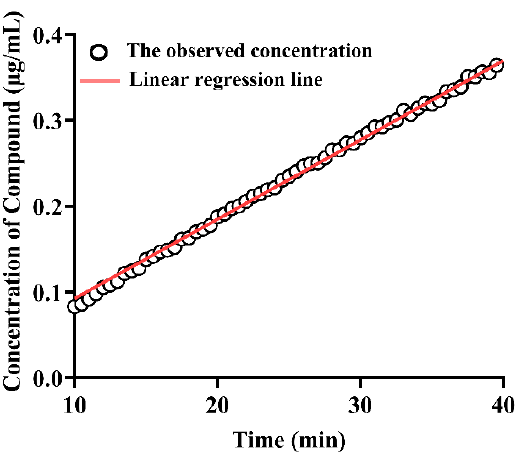
Figure 6. The correlation between concentration and time in the IDR experiments.